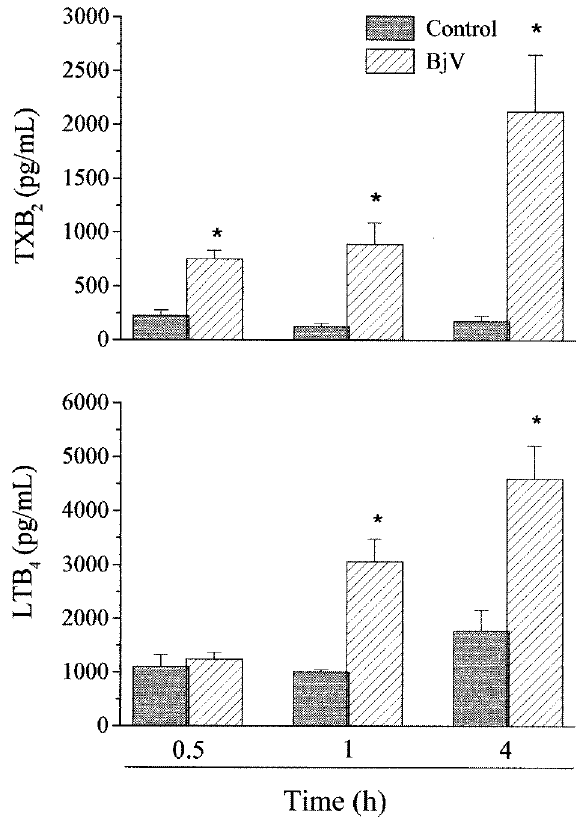
FIG. 2. LTB 4 and TXB 2 concentration in the peritoneal exudate after BjV injection. Groups of animals were injected i.p. with BjV (250 m g/kg) or sterile saline (control). Concentra- tion of LTB 4 and TXB 2 was evaluated by specific EIA in peritoneal washes collected 30, 60 and 240min after injec- tion. Each bar represents the mean ± SEM from four animals. * p < 0.05 compared with control.